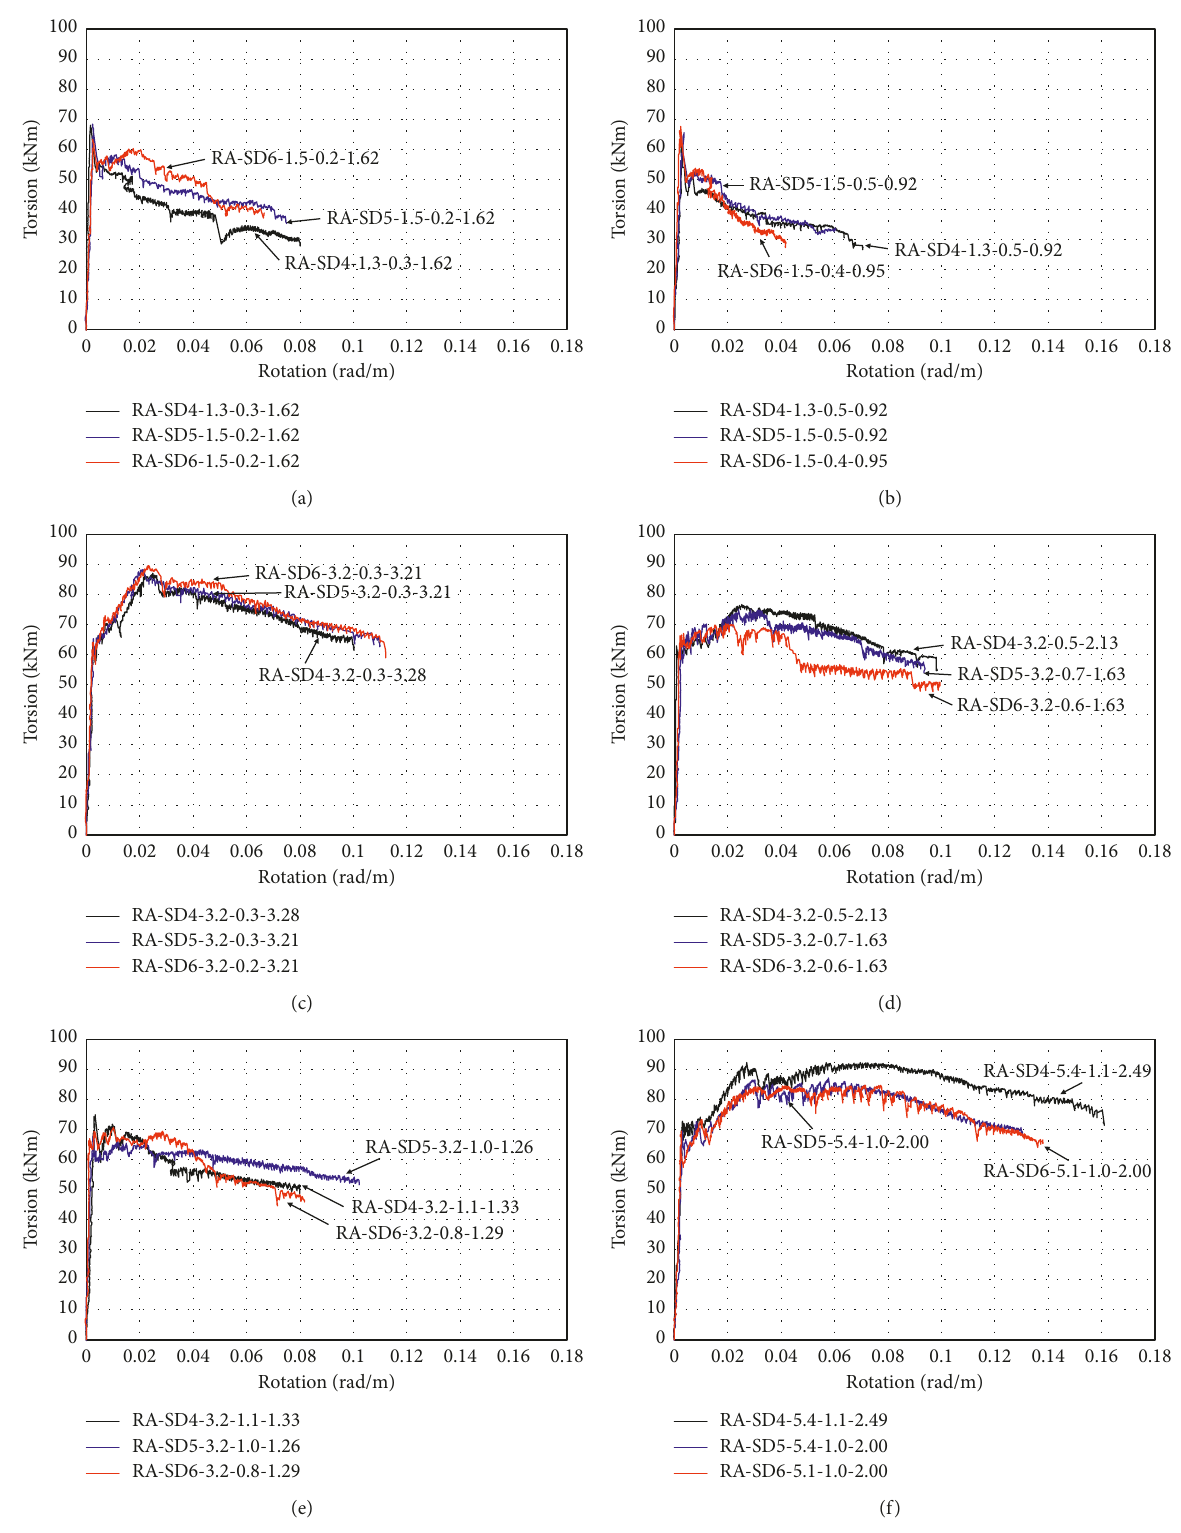
Figure 6: Torsional behavior of high-strength beams. (a) Series 1. (b) Series 2. (c) Series 3. (d) Series 4. (e) Series 5. (f) Series